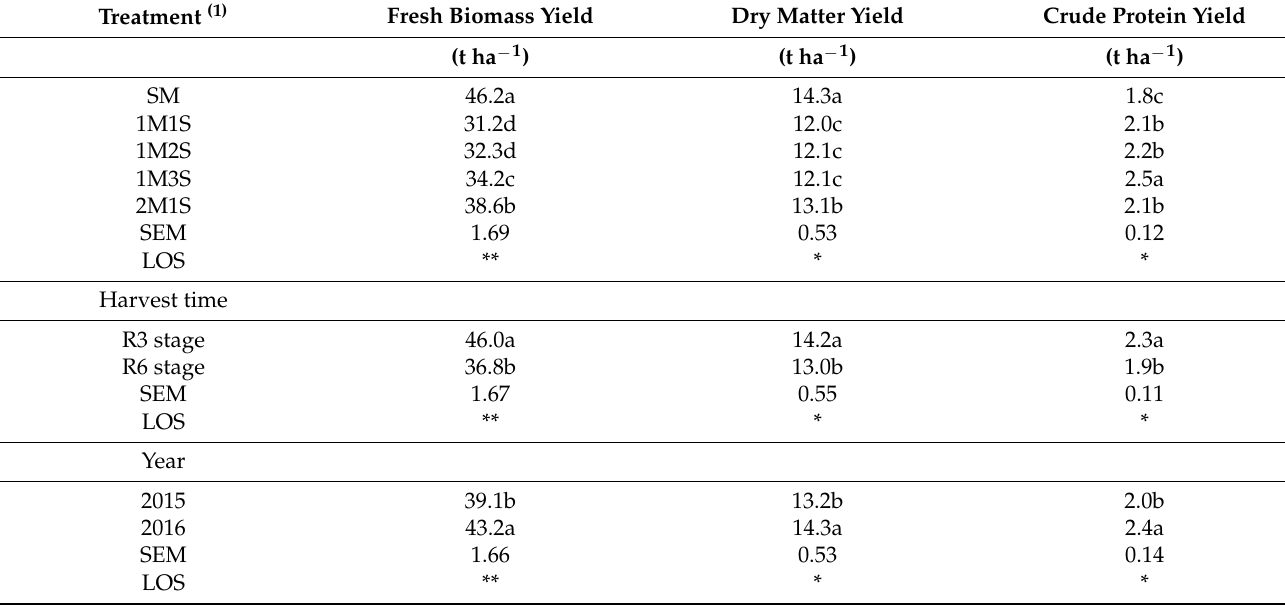
Table 1. Fresh biomass, dry matter and crude protein yield of maize and intercropped maize-soybean fodders.